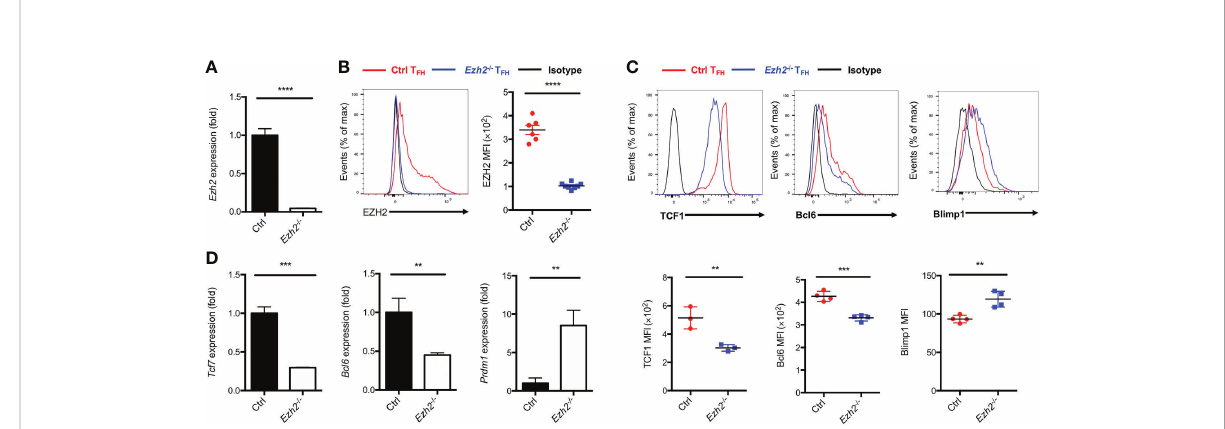
FIGURE 1 Epigenetic regulator EZH2 controls T FH differentiation. The control ( Ezh2 fl / fl ) and Ezh2 fl / fl Cd4 -cre ( Ezh2 -/- ) mice were infected with 2 × 10 5 plaque-forming units LCMV-Armstrong strain. After 8 days of infection, T FH (SLAM - CXCR5 hi CD44 + ), sorted to perform the following experiments. (A) Analysis of mRNA of Ezh2 in naive splenic CD4 + T cells from control and Ezh2 -/- mice via RT-PCR. Normalized to their expression in control CD4 + T cells. (B) Measurement of EZH2 expression in T FH cells via fl ow cytometry from control and Ezh2 -/- mice. (C, D) Measurement of TCF1, Bcl6 and Blimp1 expression via fl ow cytometry, and the expression of Tcf7 , Bcl6 and Prdm1 transcripts by RT-PCR in T FH cells from control and Ezh2 -/- mice. Normalized to their expression in control T FH cells. P value was calculated by unpaired two-tailed Student ’ s t test from triplicate experiments. Error bars indicate mean ± SEM, ** P < 0.01, *** P < 0.001, **** P <